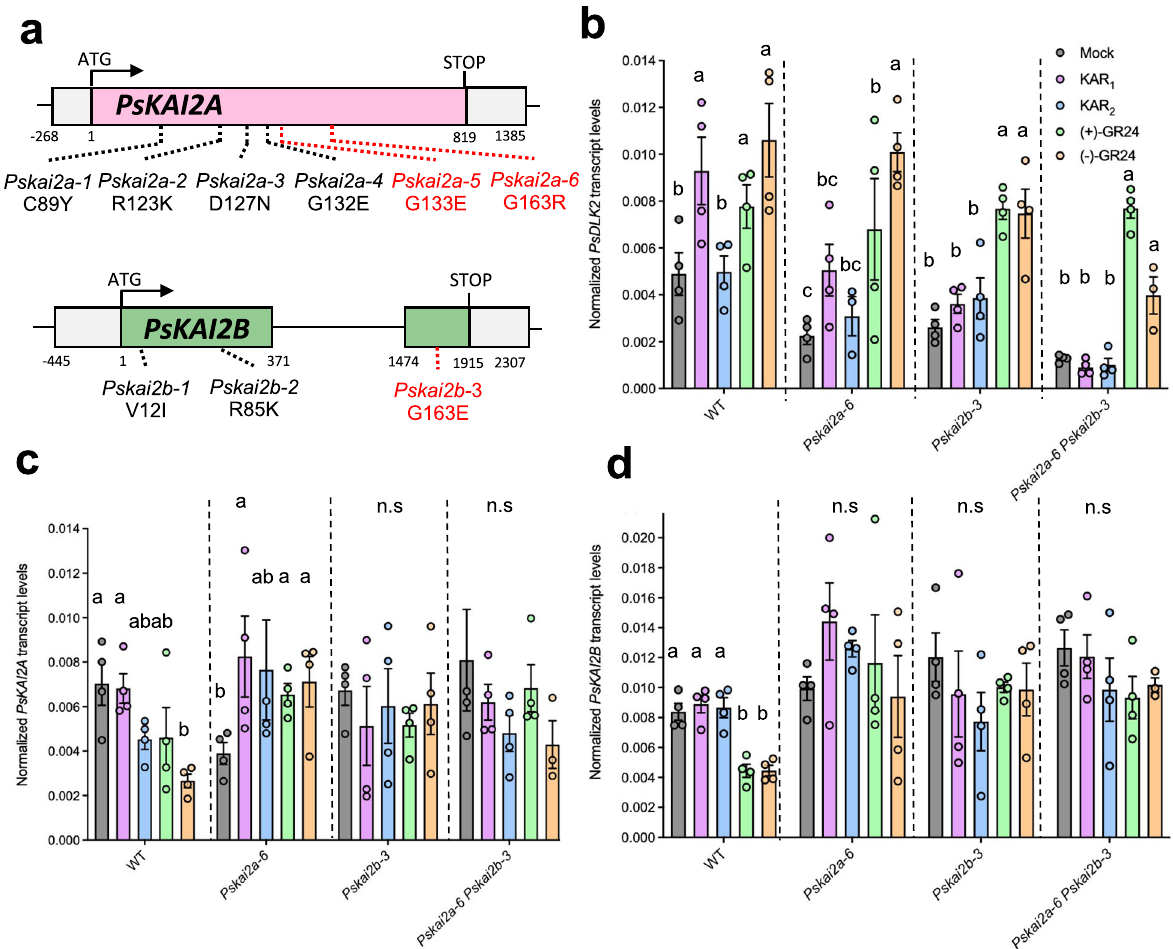
Fig. 2 Characterization of the Pskai2 mutants. a Gene structure of PsKAI2 and locations of mutations. Bases are numbered from the start codon. Point mutations are indicated by dotted lines (black and red for the one studied here). RT-qPCR-based expression of PsDLK2 ( b ), PsKAI2A ( c ), PsKAI2B ( d ) in roots of 10 day old P. sativum plants after 4 h treatment with solvent (Mock) or 3 μ M KAR 1 OR KAR 2 or ( + )-GR24 or ( – )-GR24. Expression values were normalized to those of the housekeeping gene TUBULIN ( n = 3 – 4). a – c Letters indicate signi fi cant differences versus mock treatment (Kruskal-Wallis Test, p <